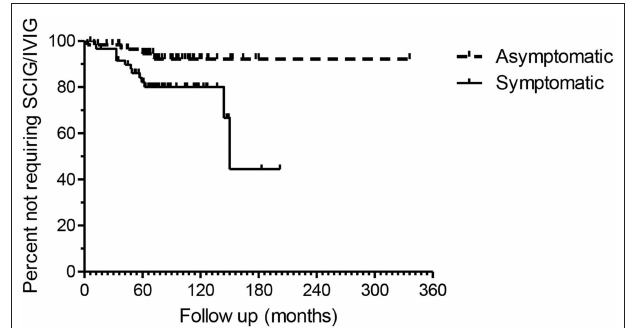
FIGURE 4 | Kaplan–Meier plots of the asymptomatic and symptomatic patients. The endpoint is time to SCIG/IVIG treatment. The duration of observation is based on the first available IgG level in NHI-linked electronic records. The difference in the two survival curves is highly significant ( p = 0.0147), Log rank Mantel Cox test.